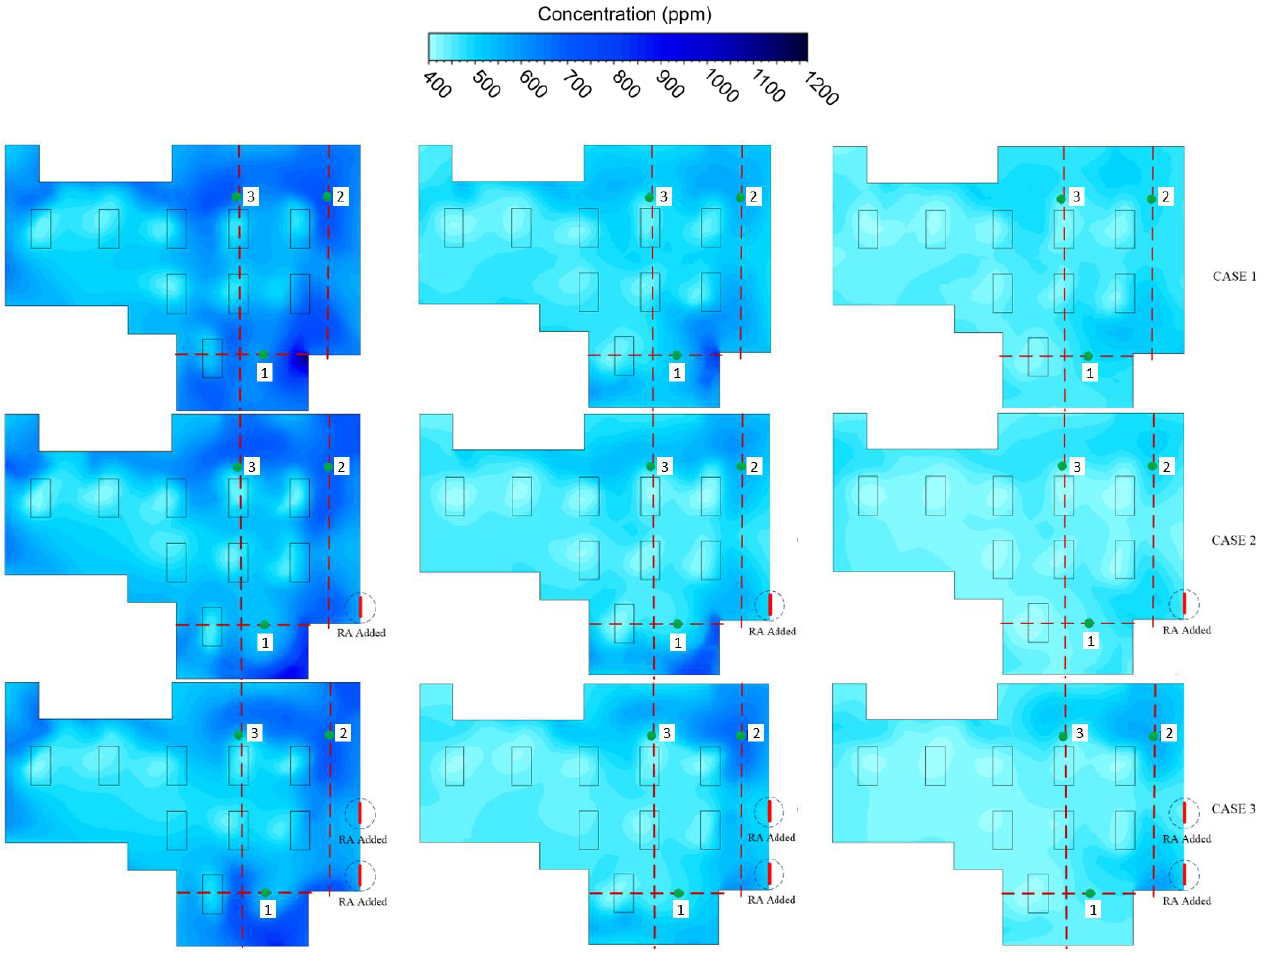
Figure 8. Contaminant concentration profile for different cases.